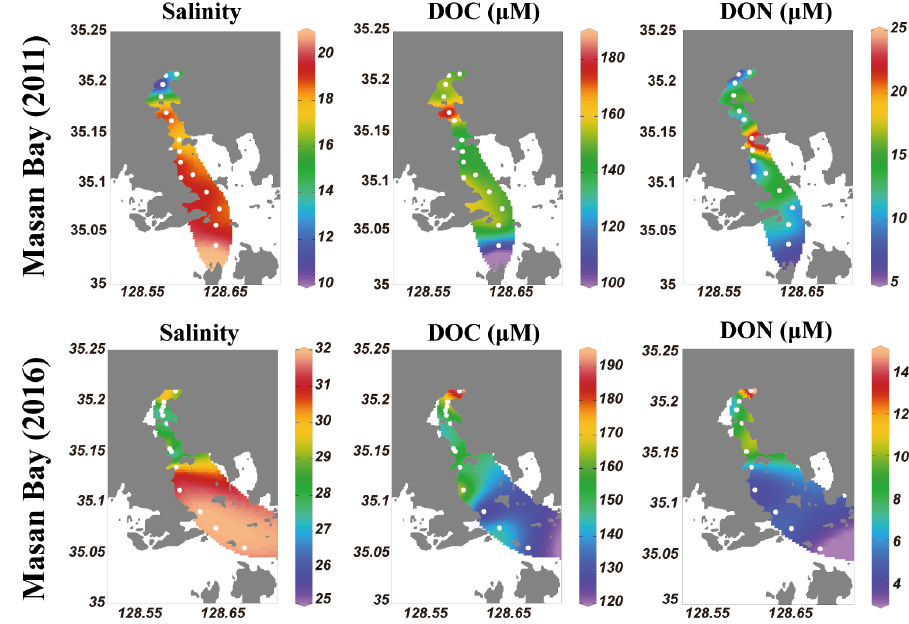
Figure 2. Surface distributions of salinity, DOC, and DON in Masan Bay, Republic of Korea, in 2011 and